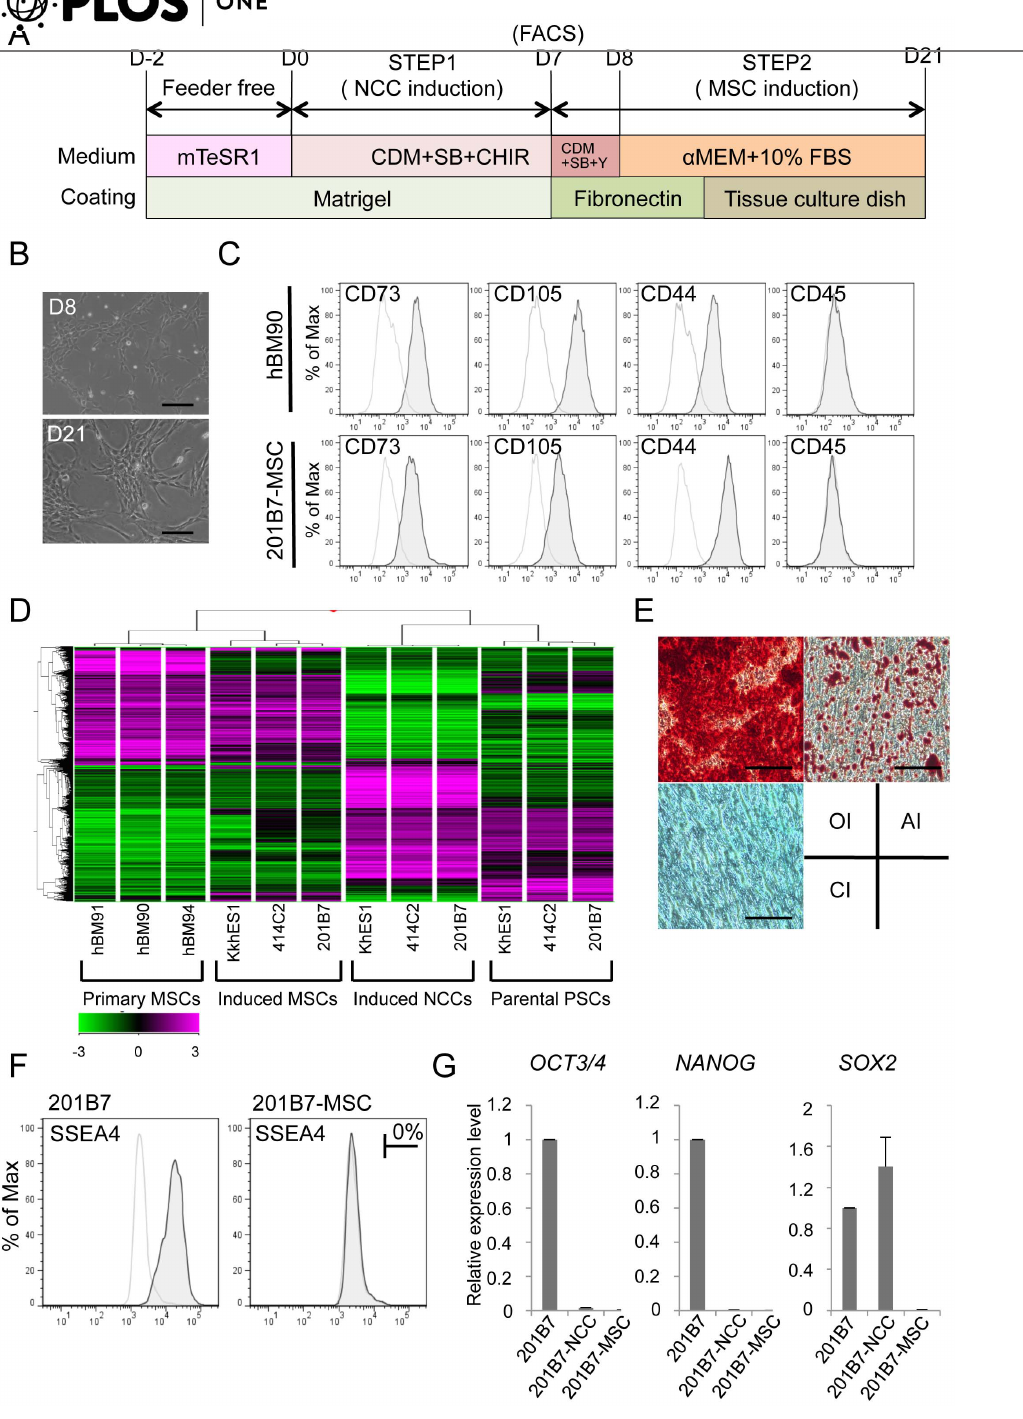
Figure 7. Derivation of hMSCs from hNCCs. A) Schematic protocol for the induction of hMSCs. B) Phase contrast images of cells before (D8) and after (D21) the induction. Scale bar, 200 m m. C) Expression of surface markers in hBM-MSCs (hBM90) and 201B7-derived MSCs (201B7-MSC). D) Hierarchical clustering analyses by genome-wide gene expression profiles. RNAs were extracted from hBM-MSCs (BM90, BM91 and BM94), induced-MSCs, and the corresponding hNCCs and hiPSCs. E) Differentiation properties of induced-MSCs. The induction for osteogenic (OI), chondrogenic (CI), and adipogenic (AI) lineages was performed as described in the Materials and Methods section and evaluated by Alizarin Red staining (OI), Alcian Blue staining (CI), and Oil Red O staining (AI), respectively. Scale bar, 100 m m. F) Population of SSEA4-positive cells. G) The expression levels of pluripotent markers ( OCT3/4 , NANOG and SOX2 ) in hPSCs, hNCCs, and hMSCs. Average ¡ SD. N 5 3, biological